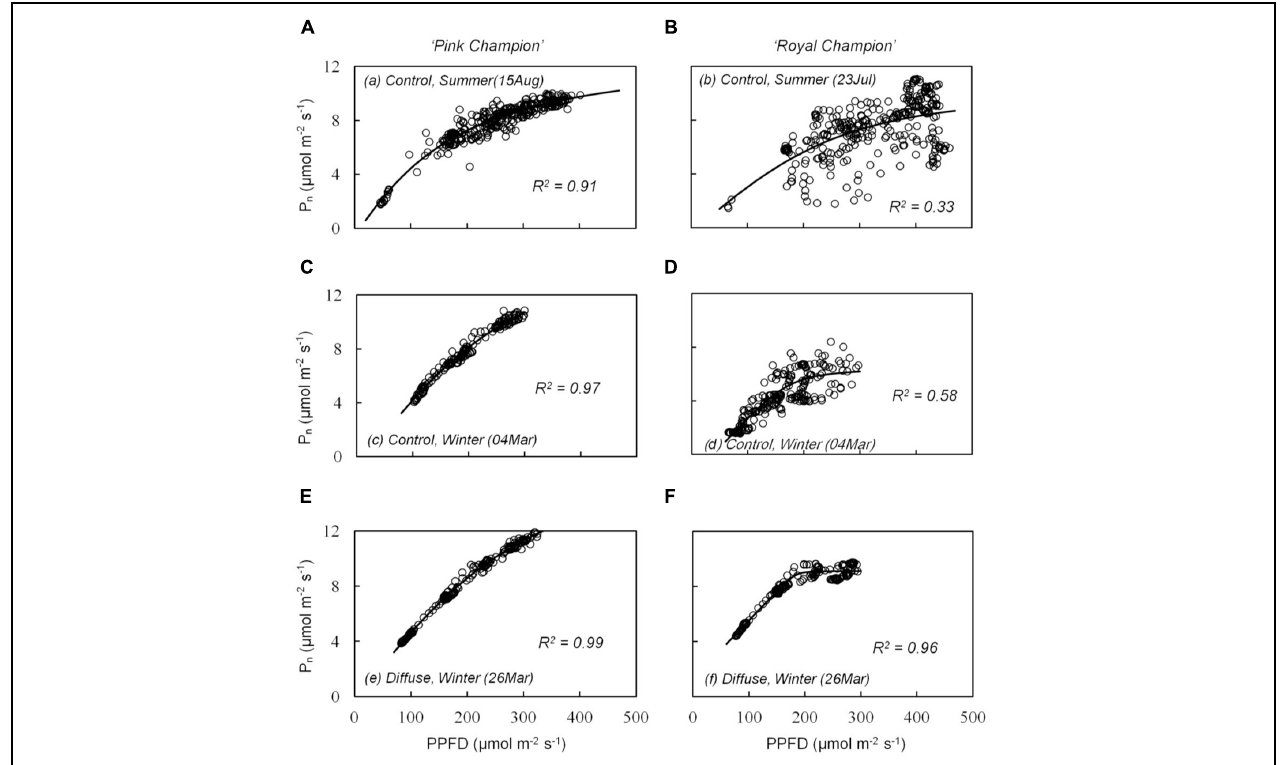
FIGURE 4 | Relationship between instantaneous net leaf photosynthesis rates ( P n ) and transient PPFD in compartment with clear glass (control: A–D) and diffuse glass (E,F). ‘Pink Champion’ is shown in (A,C,E) and ‘Royal Champion’ in (B,D,F). P n and incident PPFD were recorded at 1 min interval on one fully expanded leaf and continuously measured for 2–4 h. Lines represent the best fit of a non-rectangular hyperbola (Eq. 2). Each panel shows an example of one measurement (one replicate) under the specific treatment on clear